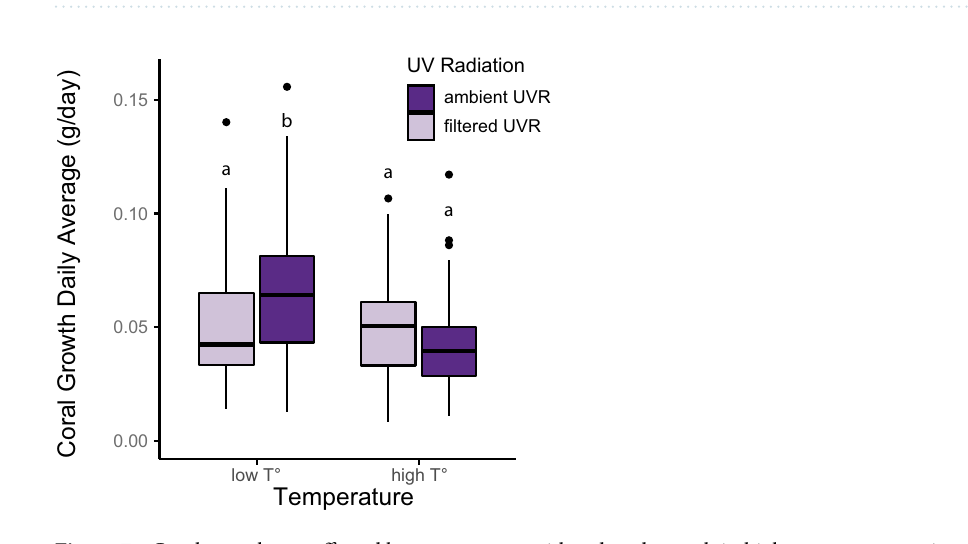
Figure 7. Coral growth was affected by temperature, with reduced growth in high temperature regimens. UVR interacted with temperature but did not have a direct effect on growth. Treatments that share the same letter are not significantly different from each